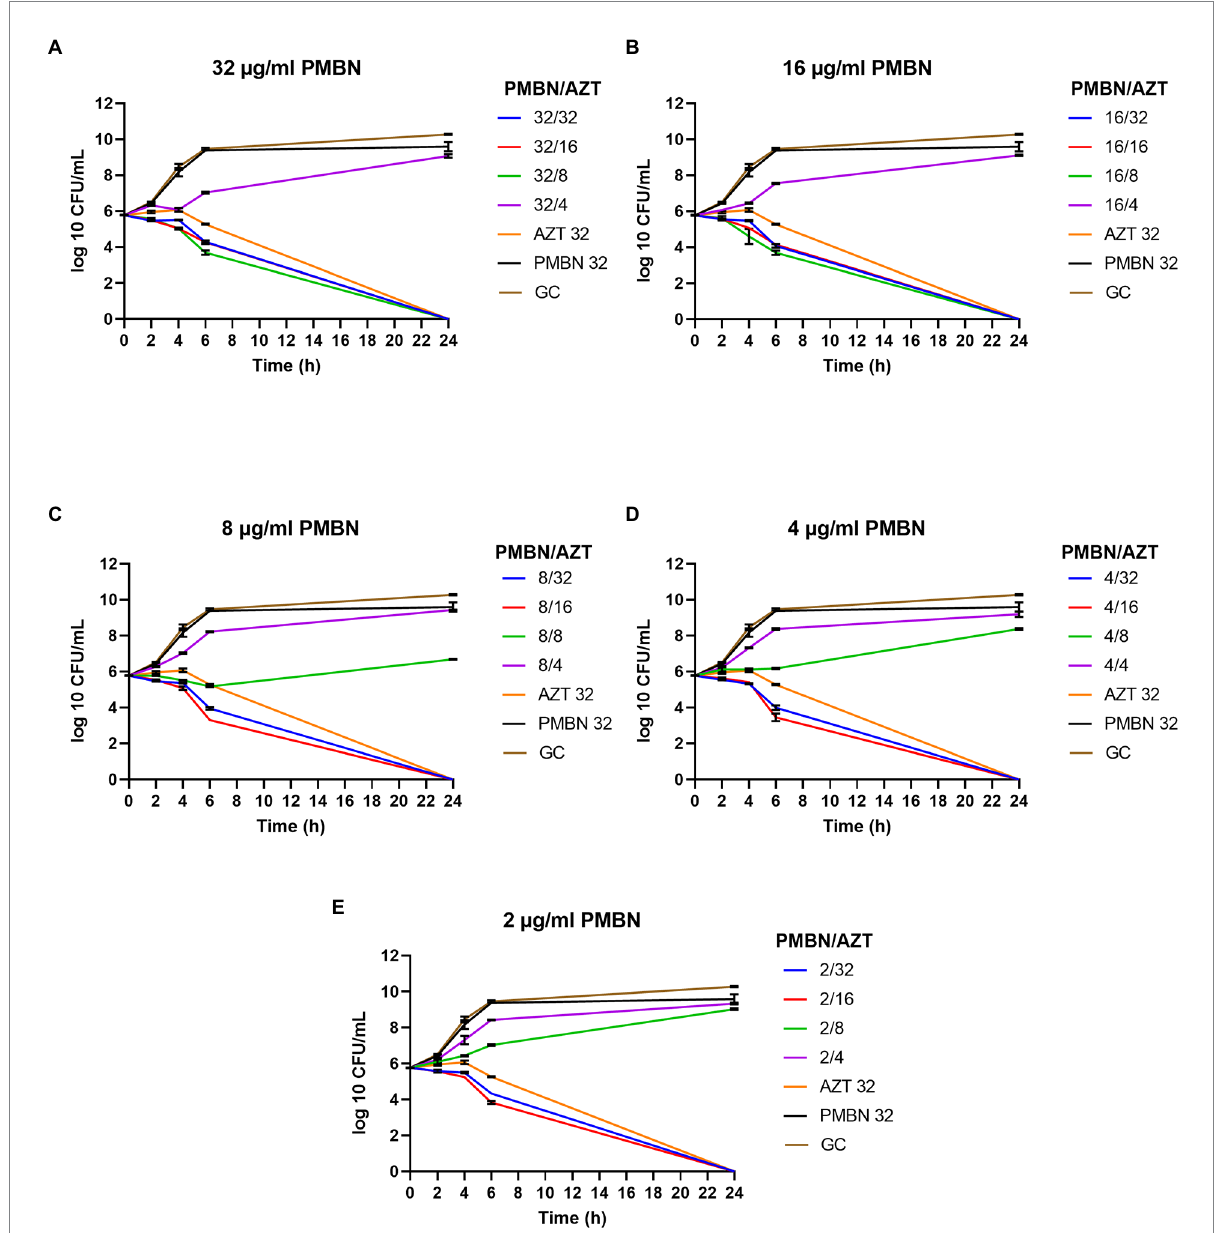
FIGURE 2 Time-kill graphs for a selected strain ( E. coli CDC AR-0346) tested with different synergistic combinations of PMBN (2–32 μ g/ml) and AZT (4– 32 μ g/ml). A single agent (AZT or PMBN) at a concentration of 32 μ g/ml were used as controls in addition to an untreated growth control (GC).